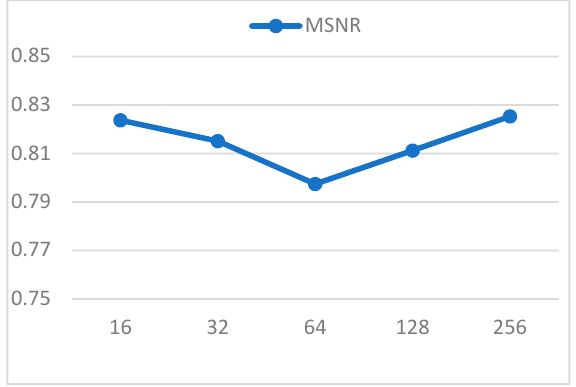
Figure 4. Effect of embedding size on MovieLens-1M datasets.